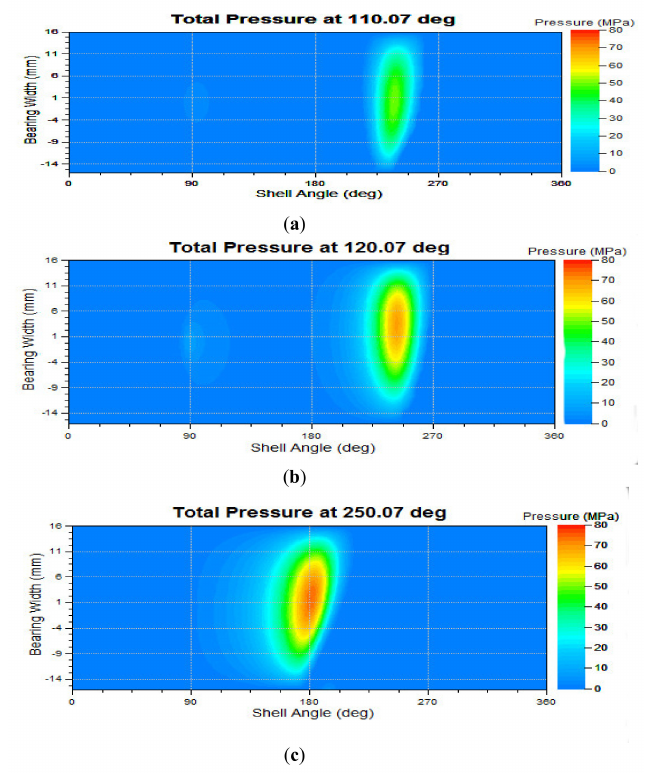
Figure 7. Specific analysis results for the test bearing simulation at 3000 r / min with 60 MPa (peak load). ( a ) Total pressure at 110.07 deg; ( b ) total pressure at 120.07 deg; and ( c ) total pressure at 250.07